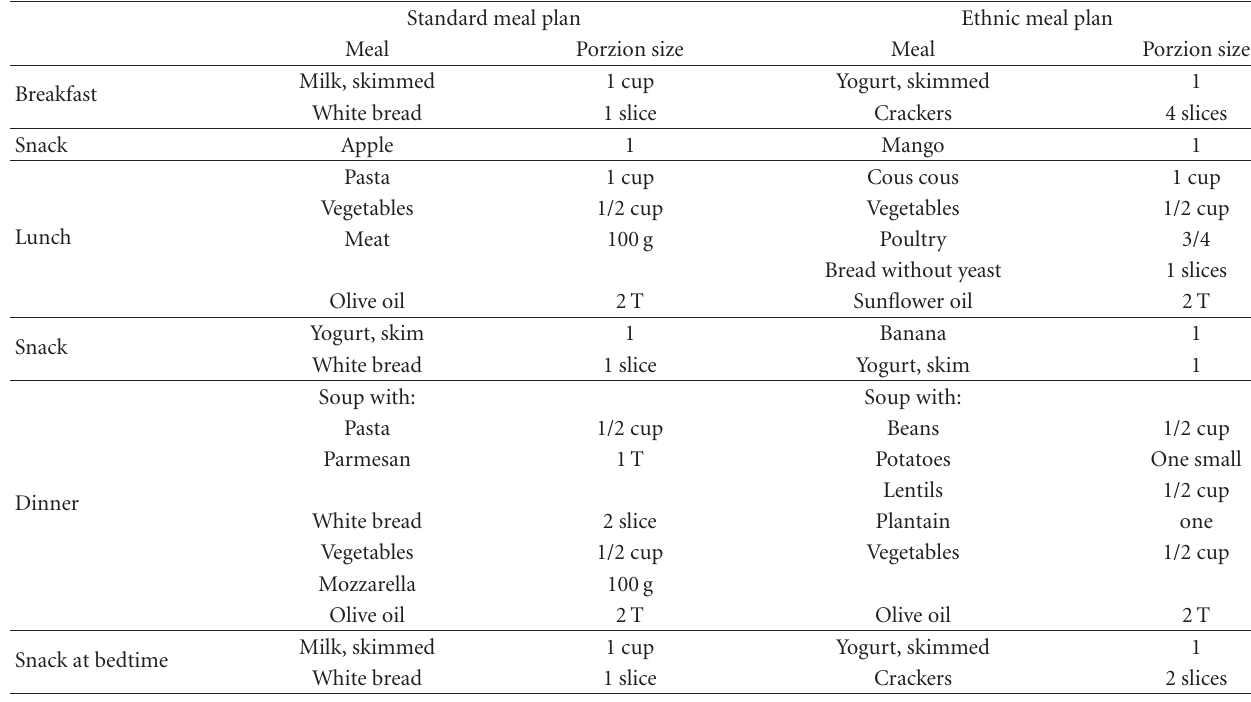
Table 1: Example of two diets on 1800